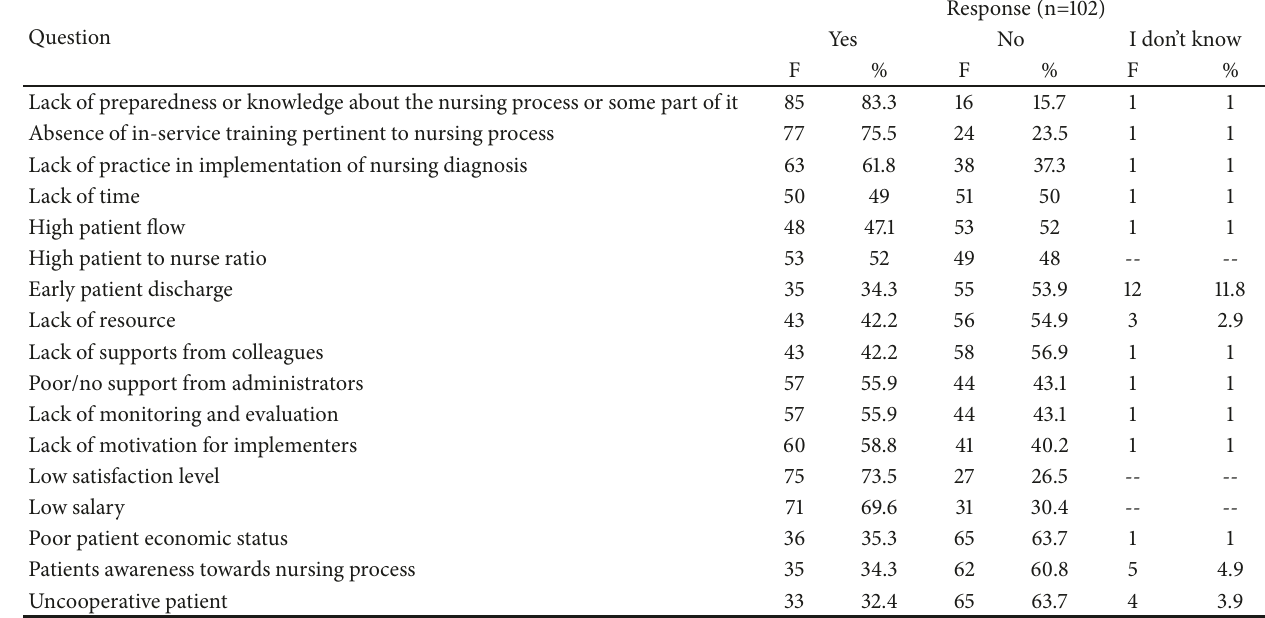
Table 4: The frequency distribution of the respondents opinion regarding the factors affecting implementation of nursing process in Afar region Hospitals, north East Ethiopia, 2016 (n=